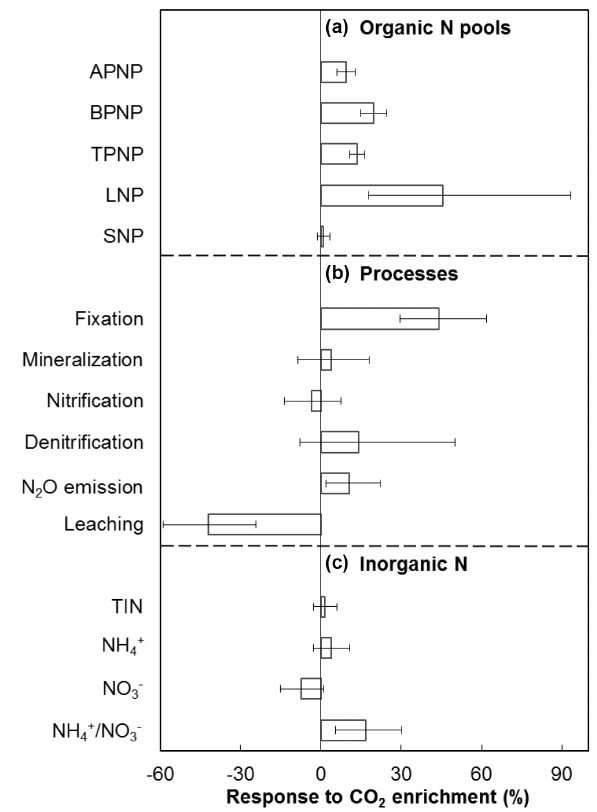
Figure 1. Results of a meta-analysis on the responses of nitro- gen pools and processes to CO 2 enrichment. In (a) , APNP, BPNP, TPNP, LNP, and SNP are the abbreviations for aboveground plant nitrogen pool, belowground plant nitrogen pool, total plant nitrogen pool, litter nitrogen pool, and soil nitrogen pool, respectively. In (c) , TIN, NH + and NO − are total inorganic nitrogen, ammonium, and 4 3 nitrate in soils, respectively. The error bars represent 95% confi- dence